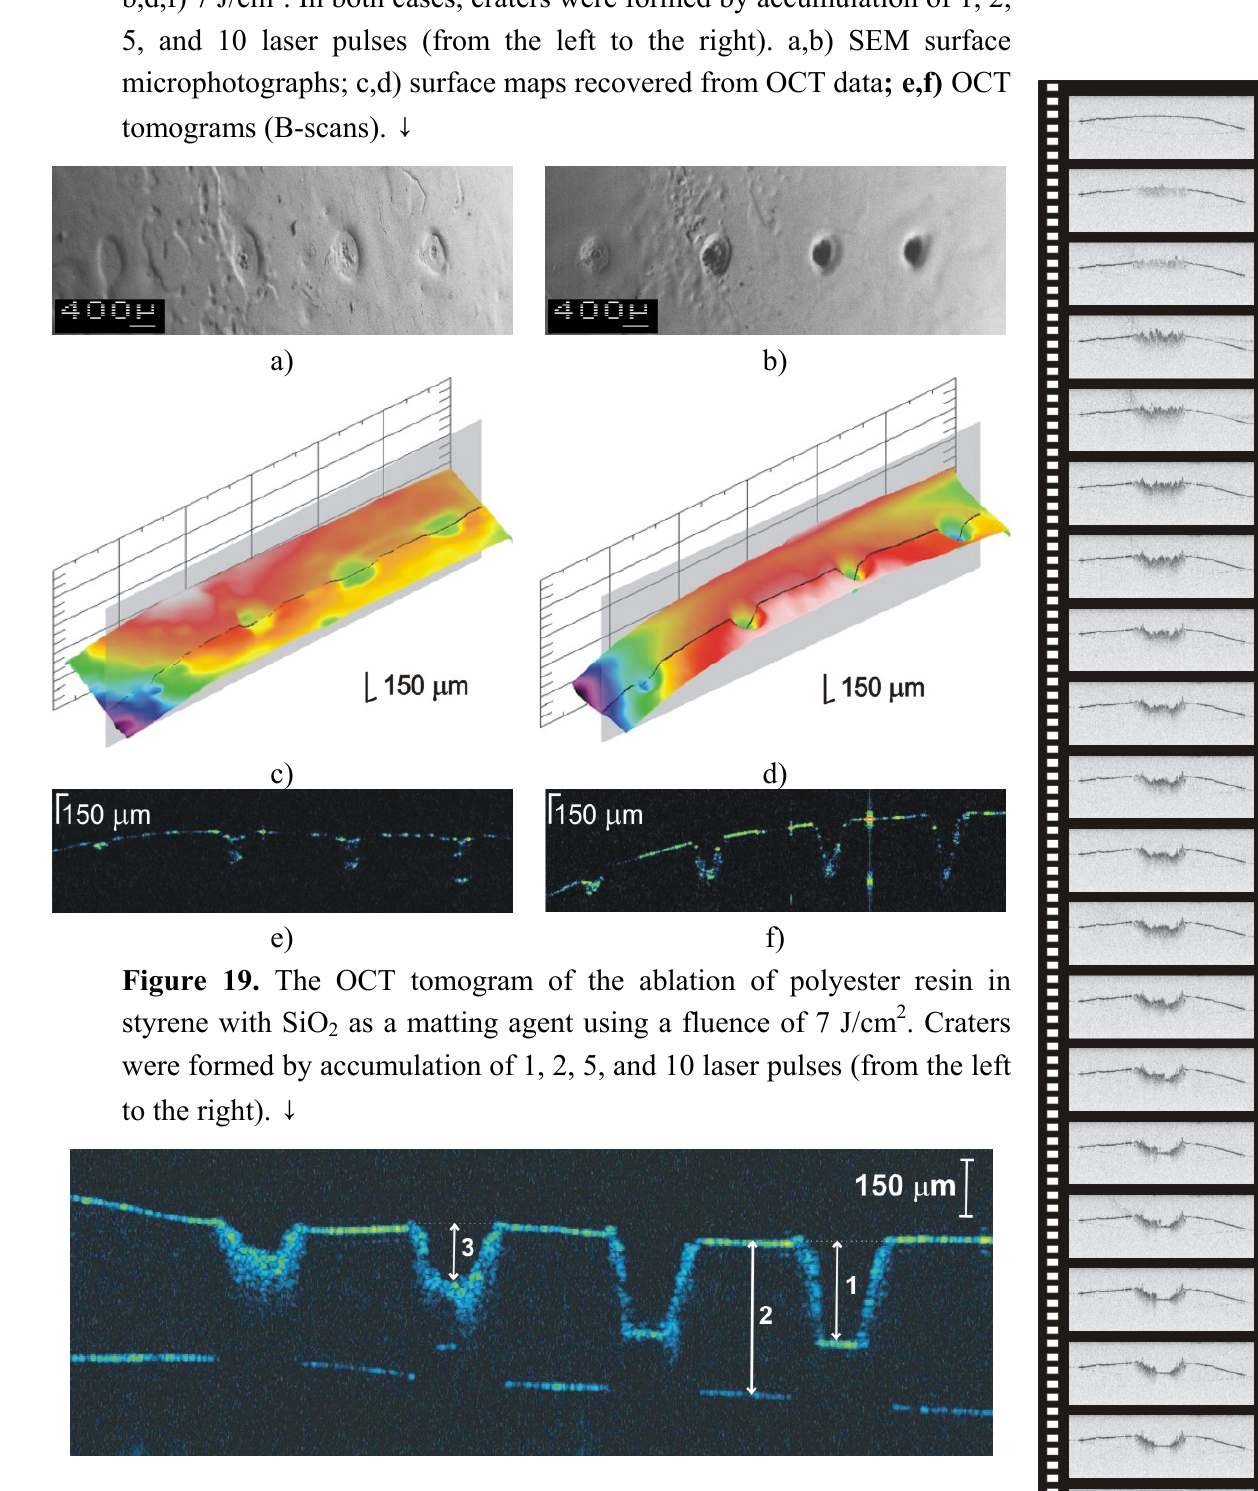
Figure 20. At the right side of page – frames, extracted from the OCT movie, registered immediately after interaction of consecutive Er: YAG laser pulses with varnish.